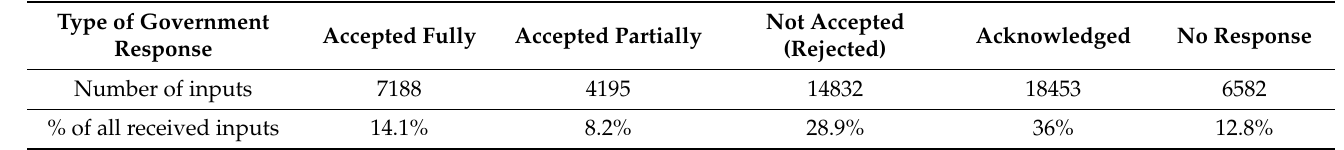
Table 4. Types of government responses (N = 51,250) to citizens and interest groups’ policy